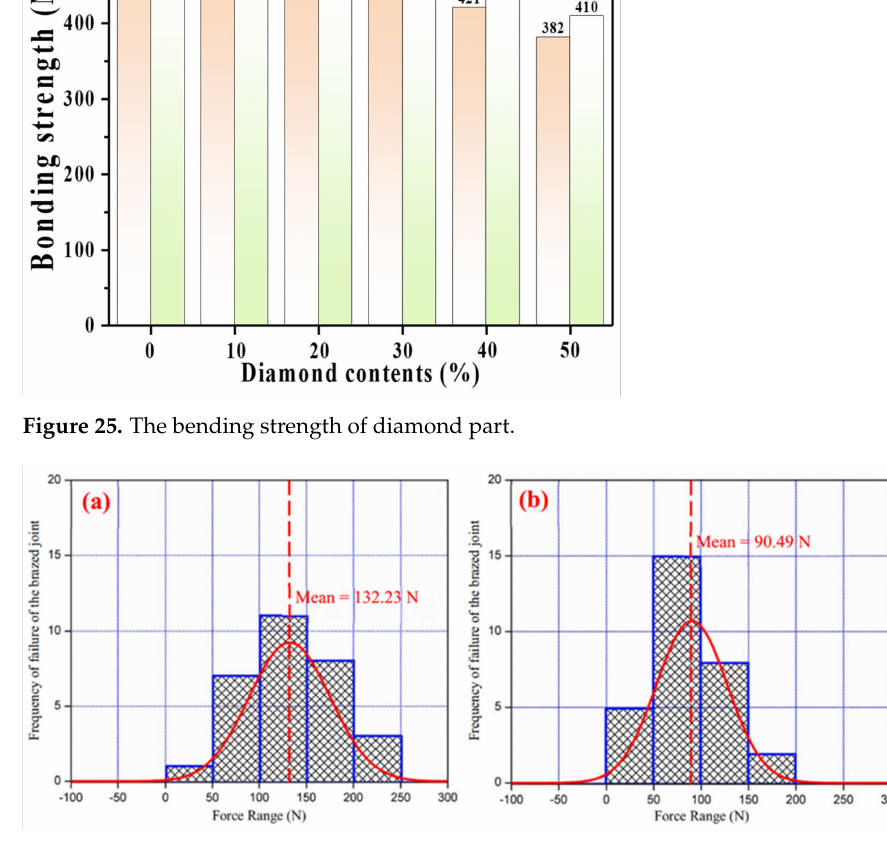
Figure 26. Brazed joint failure frequency v/s force range plot for ( a ) active Ag-Cu alloy and ( b ) Ni-Cr alloy. Reprinted with permission from Ref. [75]. Copyright 2017,